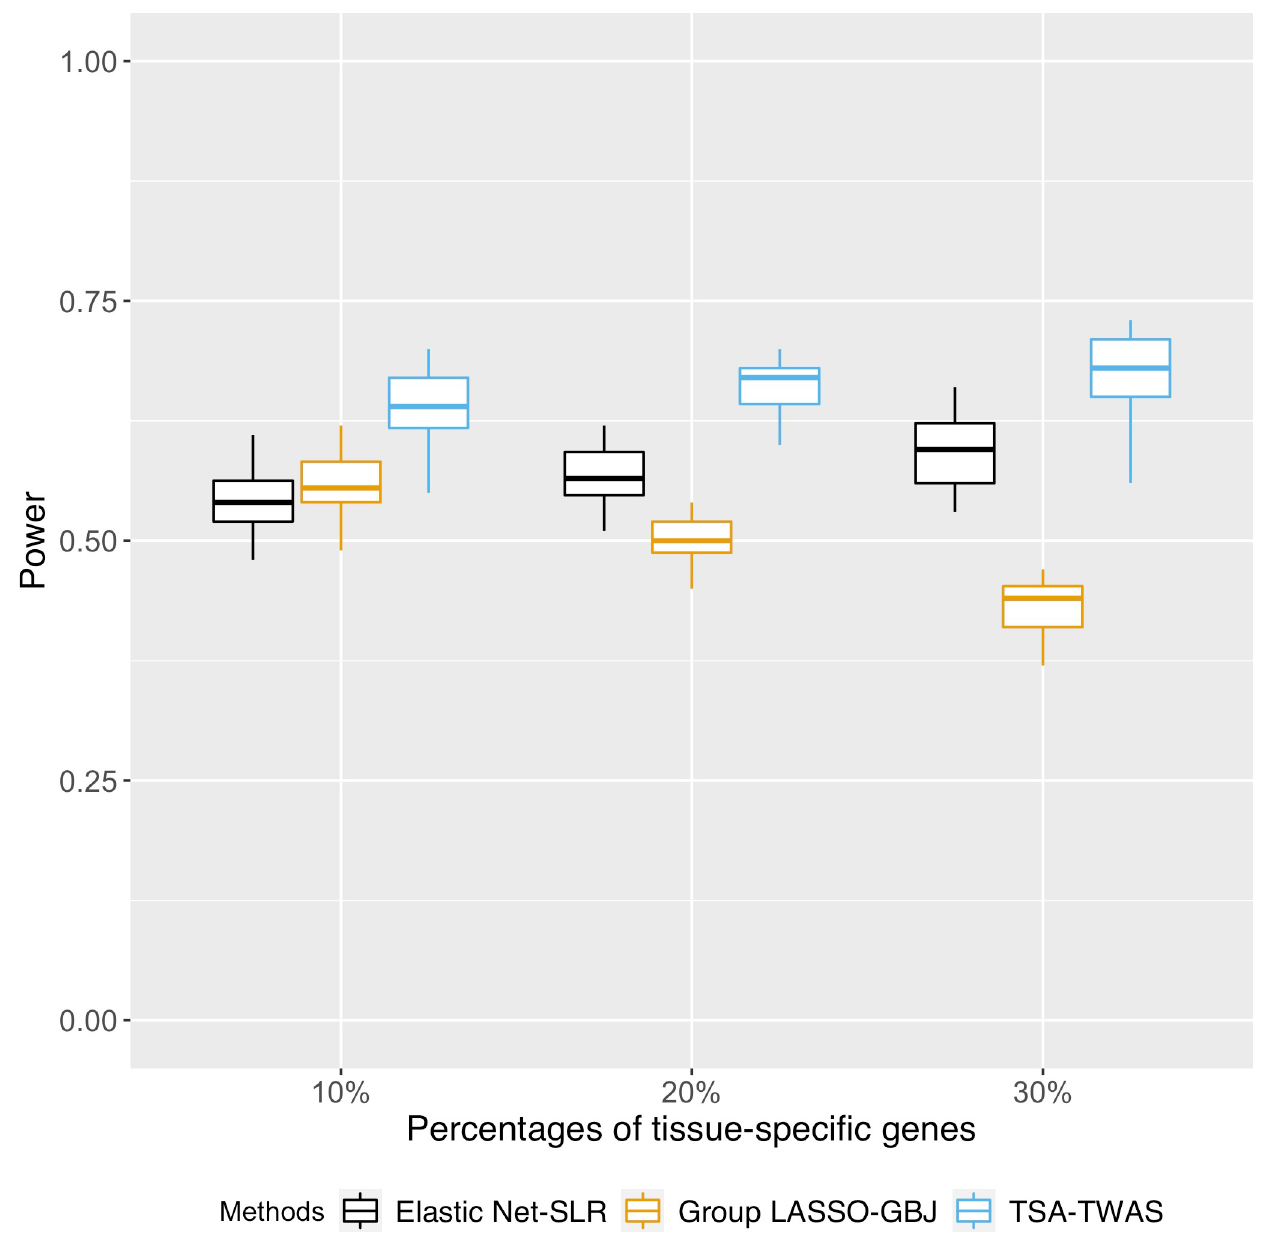
Fig 6. Power of the TSA-TWAS framework when there were different proportions of tissue-specific genes in the data. The power of TSA-TWAS was compared to only running single-tissue TWAS (elastic net-SLR) and cross-tissue TWAS (Group LASSO-GBJ test). TSA-TWAS had consistent power of identifying complex trait-related genes and was robust to makeups of tissue-specific and multi-tissue genes in a dataset.